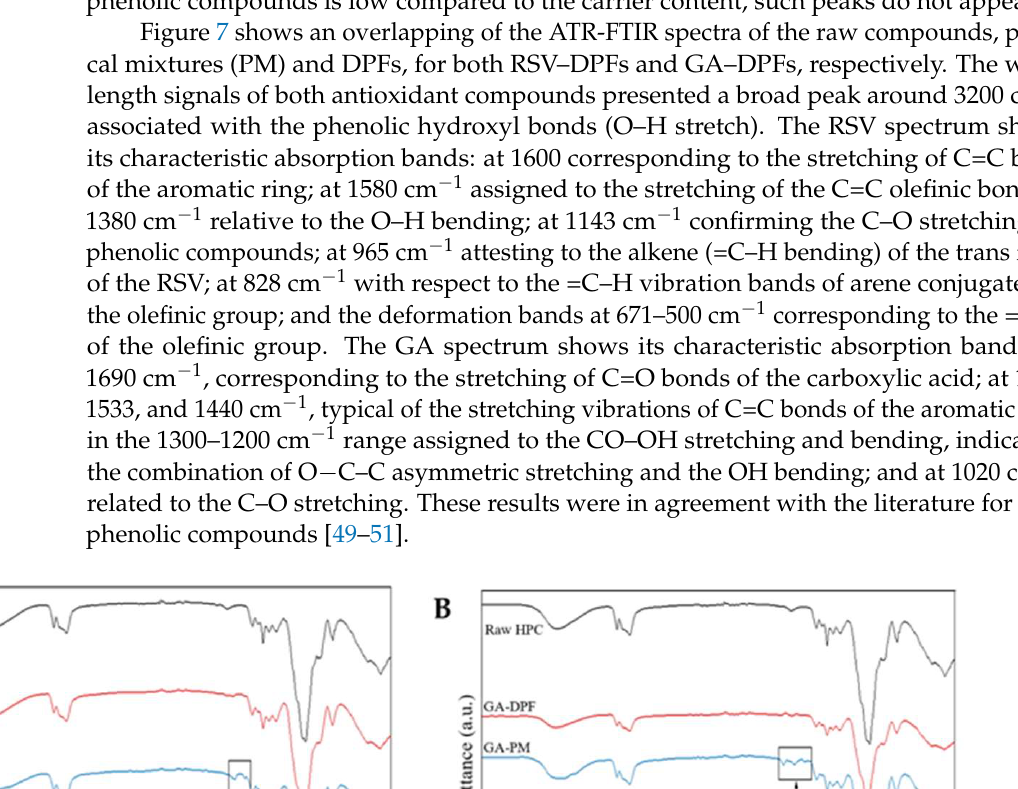
Figure 8. Antioxidant activity of raw materials and SASD-processed formulations with ( A ) RSV and ( B ) GA. Figure 8A shows that all the processed DPFs have a slightly lower antioxidant activity than the raw forms, among which those with higher solid content, namely RSV/7.5/20 and RSV/7.5/70, exhibit greater antioxidant activity. This indicates that higher RSV concentrations in the initial SASD feed formulation increase the final DPF antioxidant capacity. The curve tends to stabilize for all samples as concentrations reach 2000 µM, meaning that the RSV antioxidant power is depleted as it acts as a limiting reagent. Figure 8B shows that the two GA–DPFs with higher solid content (GA/7.5/20 and GA/7.5/70) presented greater antioxidation up to about 1300 µM. Those with lesser solid content (GA/5.0/45) consistently demonstrated lower antioxidation as a result of lower phenolic loading in the formulation. The curve fluctuates, however, more due to the greater associated error and the last point suggests an activity increase similar to other